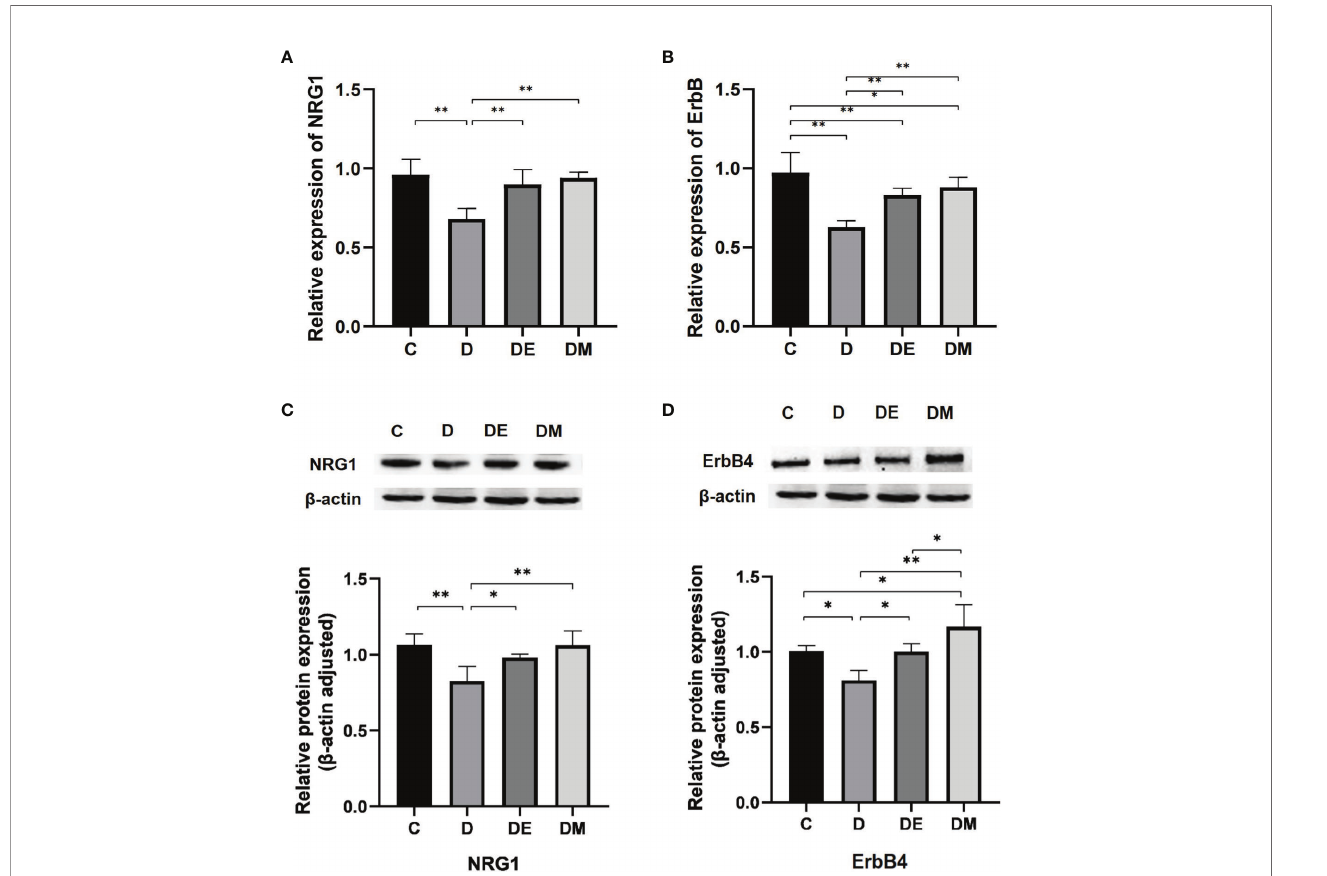
FIGURE 6 | The mRNA expressions of NRG1 and ErbB. (A, B) Rats from group D had lower NRG1 and ErbB mRNA expression compared with groups C, DE and DM (all p < 0.01), while the ErbB mRNA expression of rats in group C was higher than groups DE (p < 0.01) and DM (p < 0.05). (C, D) The protein levels of NRG1 (p < 0.01) and ErbB4 (p < 0.05) were signi fi cantly lower in group D than group C NRG1 and ErbB protein levels were signi fi cantly higher in group DE (both p < 0.05 and very signi fi cantly higher in group DM (both p < 0.01) than those in group D n = 10 rats per group; *p < 0.05, **p < 0.01; C (control), D (diabetic), DE (diabetic + exercise), DM (diabetic +